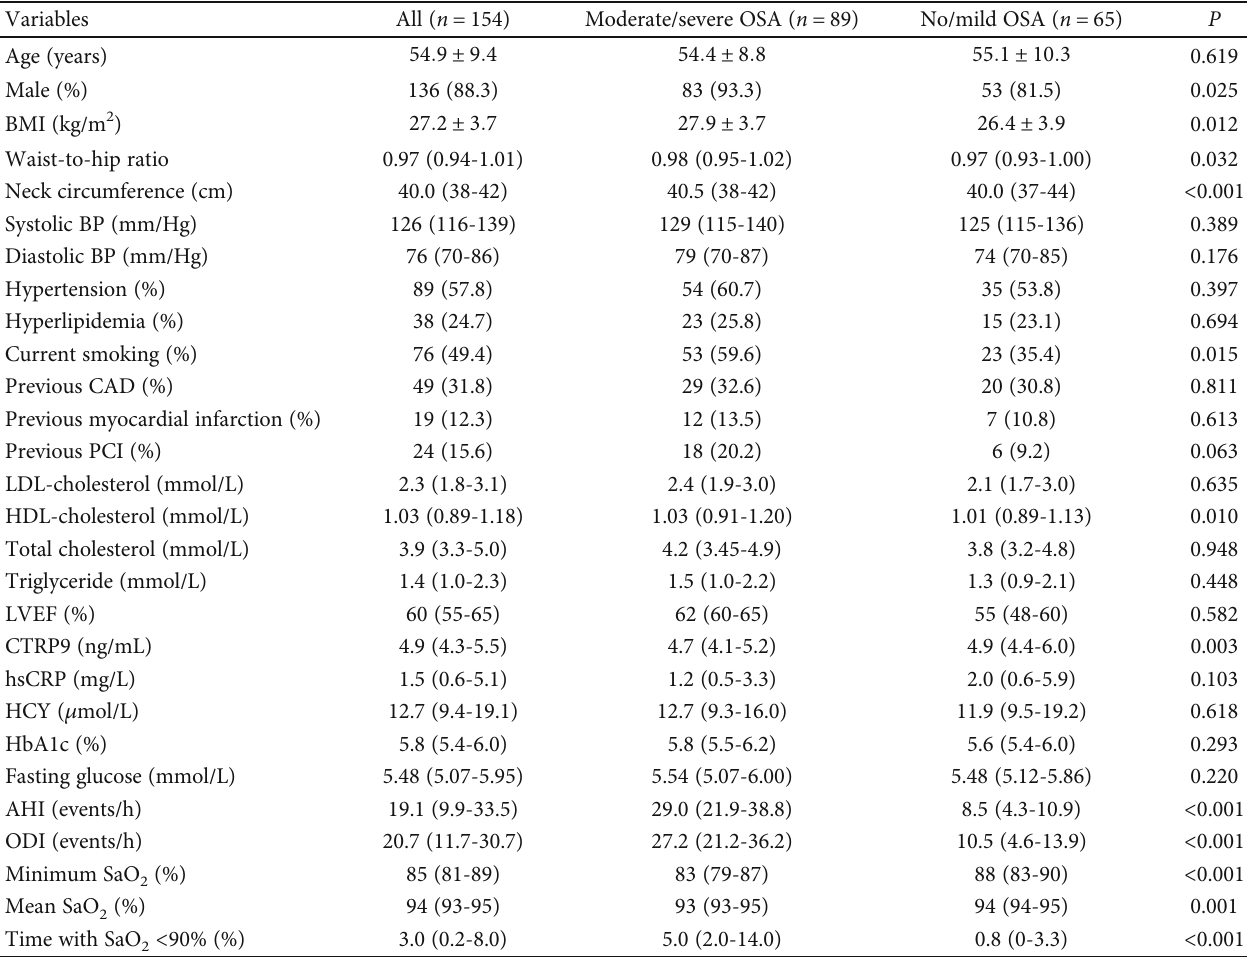
Table 1: Baseline characteristics of subjects with moderate/severe OSA and no/mild OSA.